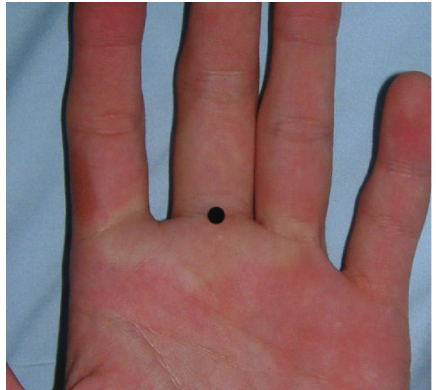
Figure 1: Subcutaneous single injection at the middle point of the palmar digital crease. Figure 2: The area around the injection point is completely white. The filled black circle is the injection point.